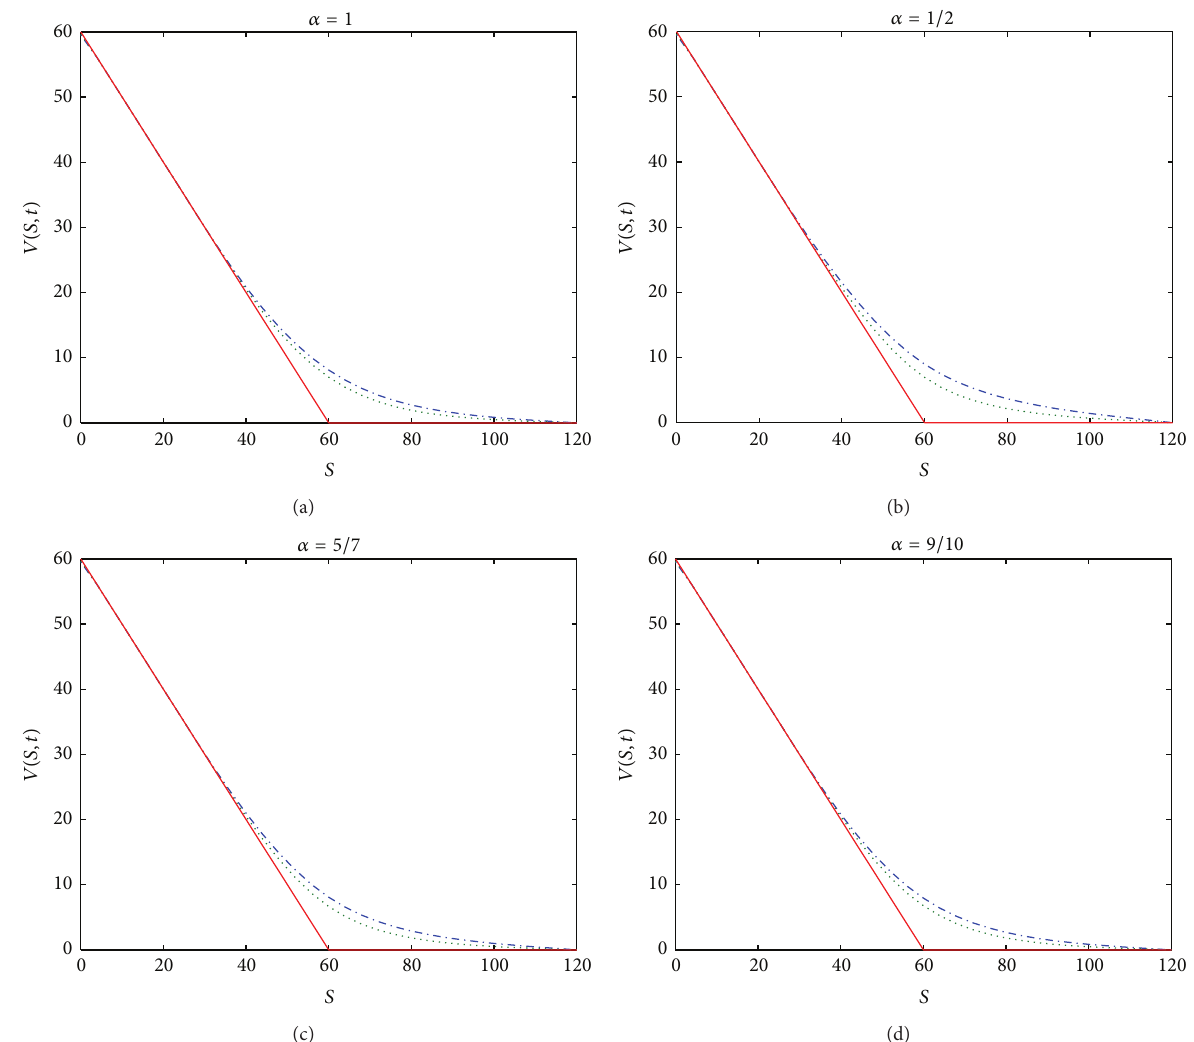
Figure 4: American put option. dash-dotted line: 𝑡 = 0.2 ; dotted line: 𝑡 = 0.6 ; solid line: 𝑡 = 1